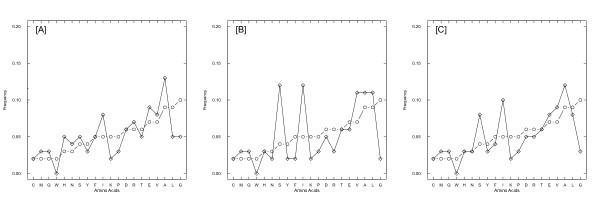
The amino acid composition at the positively selected sites ("rhombus"), as inferred with (A) PAML, (B) FitModel, and (C) both PAML and FitModel. The amino acids are ordered according to their frequency in all RBCL sequences (as shown by "circle").